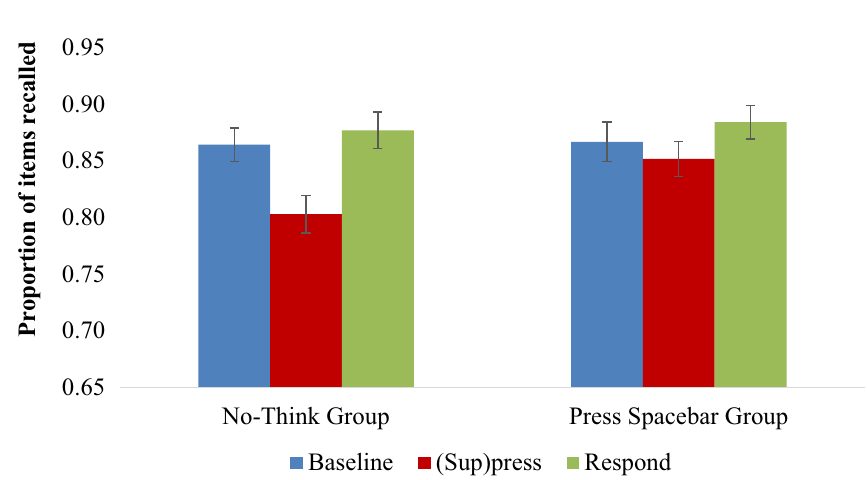
Figure 2. Mean proportion of recall for Baseline (blue), (Sup)press (red), and Respond (green) aggregated by Test Type for Experiment 2. Error bars represent standard errors of the